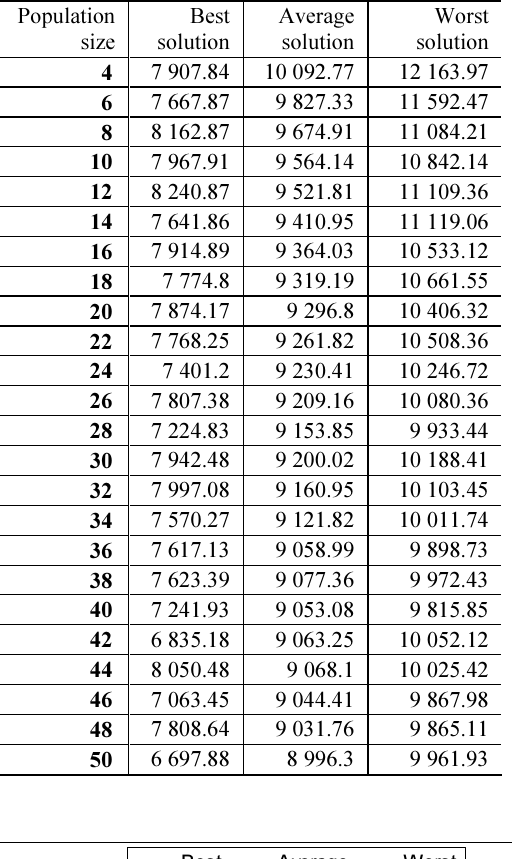
Table 2. Dependency of solution results on the population size